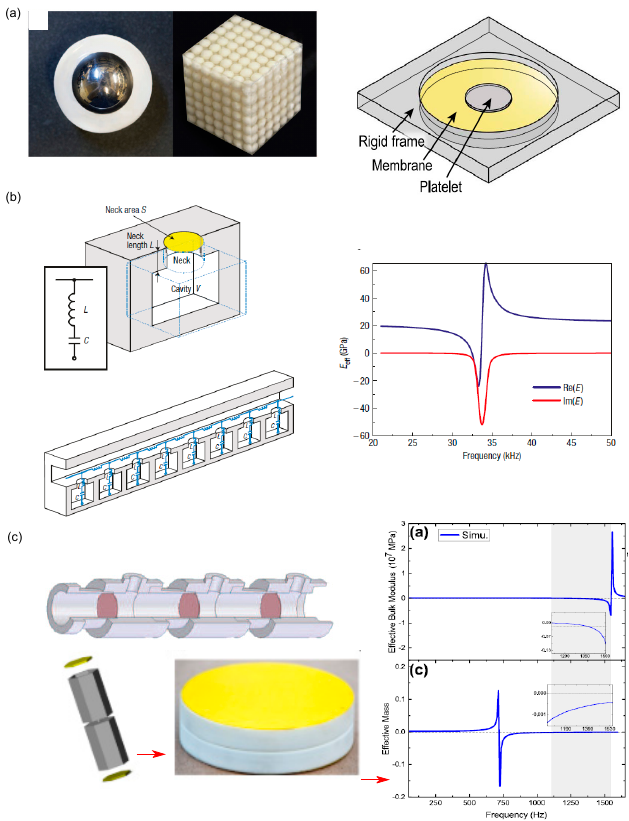
Figure 1. Examples of resonant acoustic metamaterials. ( a ) Negative mass density ( ρ < 0) schematic illustrations of sonic crystals and a decorated membrane-type metasurface. Reprinted with permission from Ma et al. [13], © 2016 Author(s) under a Creative Commons Attribution Non-Commercial License 4.0 (CC BY-NC), and Yang et al. [44], © 2015 Acad é mie des sciences, respectively. ( b ) Negative e ff ective bulk modulus ( E < 0): the Helmholtz resonator unit cell, consisting of a rectangular cavity and a cylindrical neck, filled with water. Reprinted with permission from Fang et al. [45], © 2006 Nature Publishing Group. ( c ) Double negativity ( ρ < 0, E < 0): the composite structure consisting of interspaced membranes and side holes. Reprinted with permission from Lee et al. [50], © 2020 American Physical Society. The double membrane-hexagonal cavity and the dual negative spectra are reprinted with permission from Kumar et al. [79], © 2020 AIP Publishing